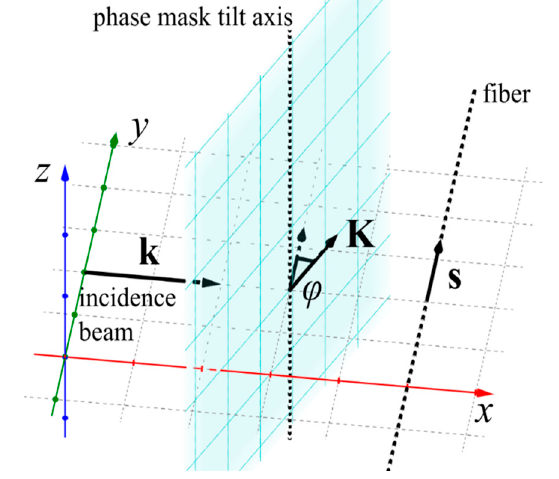
Figure 1. Schematic representation of grating inscription system. The blue plane represents the phase mask. k , wave vector of incidence beam; K , inverse vector of phase mask; s , versor indicating the fiber orientation, ϕ , tilt angle.